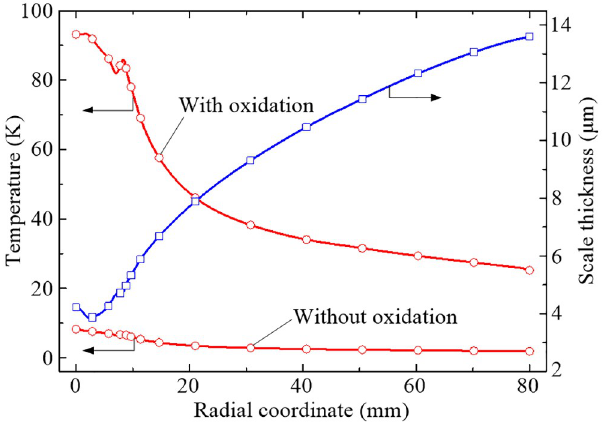
Fig 15. Distributions of scale thickness and temperature difference of the total oxide